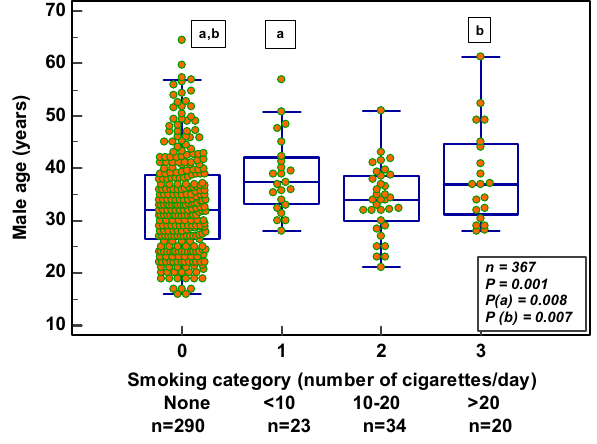
Figure 5. Relation between male age and number of cigarettes smoked per day. Similar letters demonstrate significant differences between the different smoking categories. Table 2. Effect of smoking on age, BMI, semen and SDF